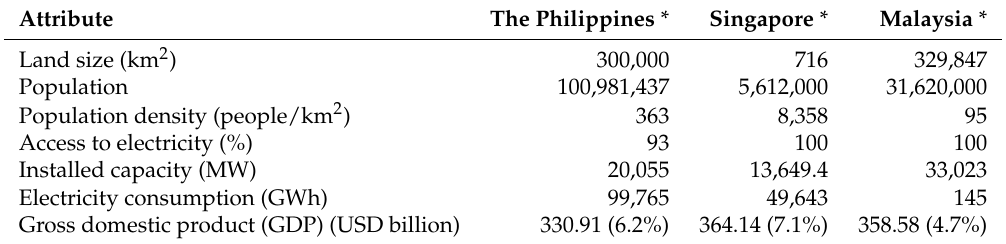
Table 7. Selected demographic information of the Philippines and